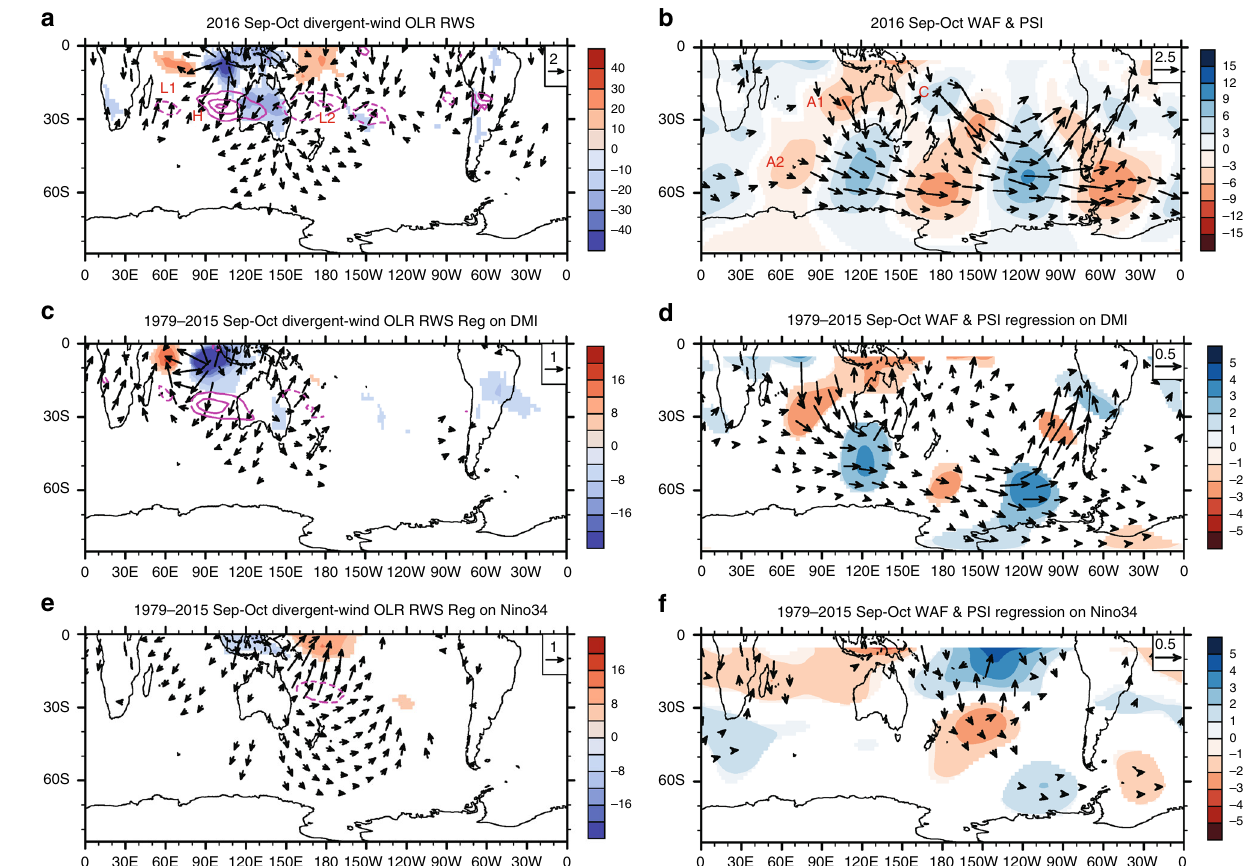
Fig. 3 Rossby wave train and source during September – October 2016. a 200 hPa divergent wind anomaly (vectors, scale in upper right, m s − 1 ), Rossby wave source (RWS, magenta contours, positive (anticyclonic) solid and negative (cyclonic) dashed, zero line omitted; interval 4 × 10 − 11 s − 2 , see Methods) and outgoing longwave radiation (OLR) anomaly (shading; interval 4 Wm − 2 ) for Sep – Oct 2016. b 200 hPa eddy streamfunction anomaly (shading; interval 3 × 10 6 m 2 s) and anomalous wave activity fl ux (WAF, vectors, m 2 s − 2 ) for Sep – Oct 2016. c – f are same as a , b but displayed fi elds are derived by multiple linear regression onto the DMI index ( c , d ) and Nino34 SST index ( e , f ) using historical data for the period 1979 – 2015 (see Methods). The anomalies in c , d and e , f are scaled by the observed magnitude of the DMI and Nino34 index, respectively, in Sep – Oct 2016. Contouring/shading is as in a and b , except RWS interval is 2 × 10 − 11 s − 2 , and eddy streamfunction interval is 1 × 10 6 m 2 s. Anomalies and regression coef fi cients are shown only for p < 0.10 using two- sided t -test. For clarity, divergent wind weaker than 0.8 ms − 1 in a , and weaker than 0.3 ms − 1 in c and e , WAF weaker than 0.8 m 2 s − 2 in b , and weaker than 0.1 m 2 s − 2 in d and f are masked. In the Southern Hemisphere, negative streamfunction anomaly corresponds to positive geopotential height anomaly and thus is coloured in reds; similarly, positive streamfunction anomaly is coloured in blues. Plots were generated using the NCAR Command Language